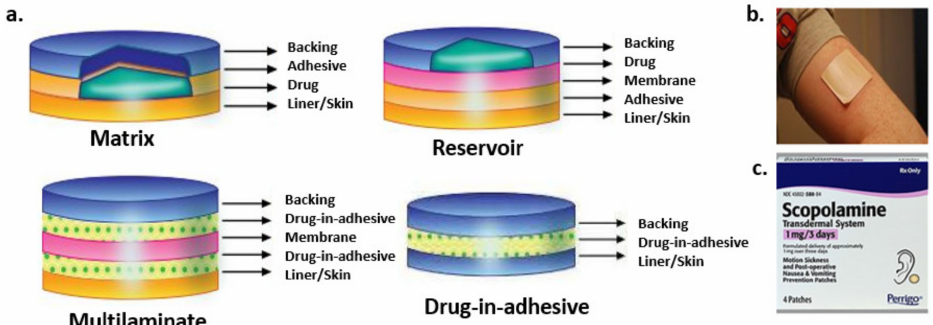
Figure 8. ( a ) Types of transdermal patches, ( b ) Transdermal patch applied on skin, ( c ) First commer- cially available Scopolamine transdermal patch (reproduced from [21] with permission from